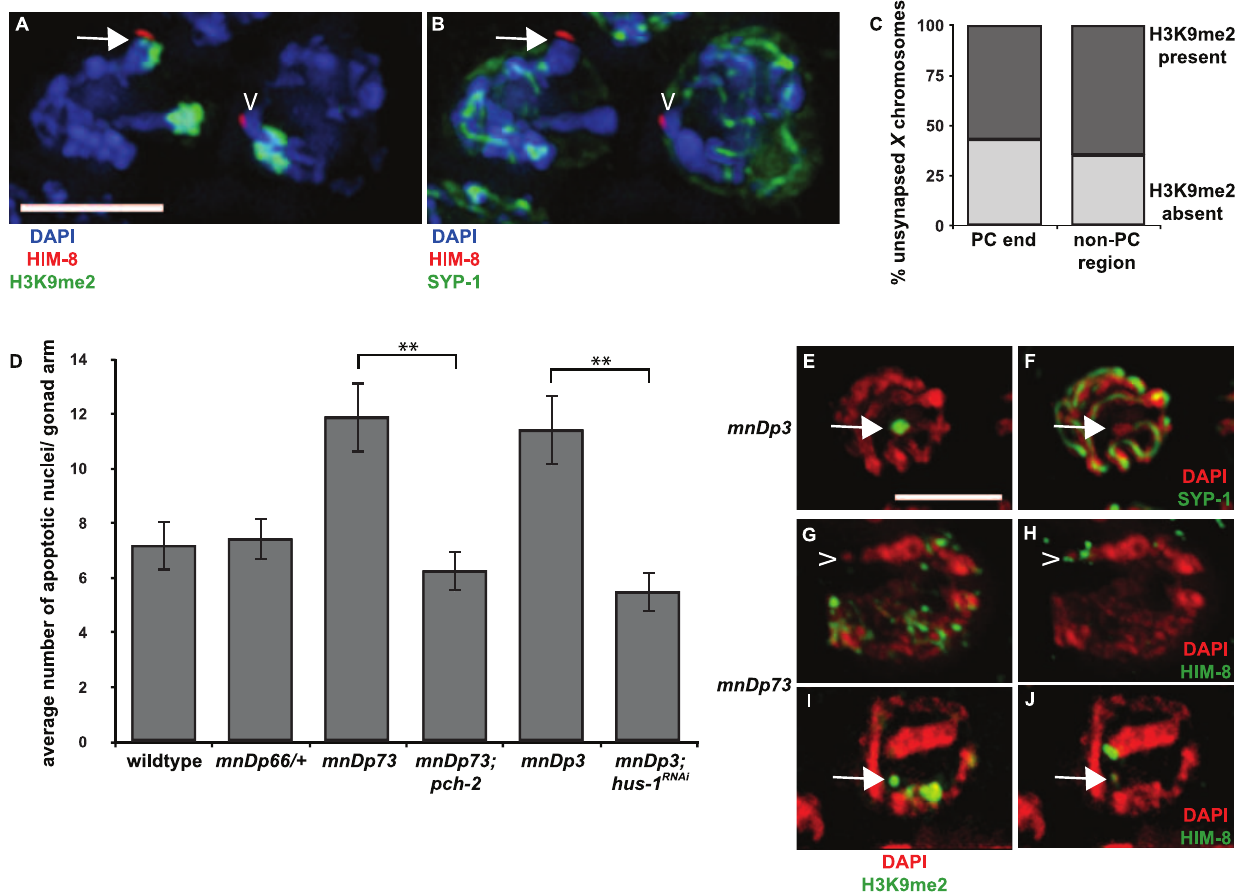
Figure 2. A chromosomal duplication with Pairing Center activity often does not undergo heterochromatin assembly. A and B. In meDf2/ + hermaphrodites, it is difficult to determine if PCs of unsynapsed X chromosomes become enriched with H3K9me2. Indirect immunofluorescence was performed on meiotic nuclei in meDf2 heterozygotes using antibodies against the X chromosome PC protein HIM-8, the central element component SYP-1 and H3K9me2. The nucleus on the left contains an unsynapsed X chromosome, as identified by HIM-8, an enrichment of H3K9me2 (A) and the absence of SYP-1 (B); the PC appears enriched with H3K9me2 (arrow in A). The nucleus on the right also contains an unsynapsed X chromosome, as indicated by the absence of SYP-1 in B, and the PC of this chromosome does not exhibit robust H3k9me2 (caret in A). C. Quantification of the percentage of unsynapsed X chromosomes in meDf2 heterozygotes that were enriched for H3K9me2 at their PC and non- PC regions. D. A chromosomal duplication with Pairing Center activity ( mnDp73 ) activates the synapsis checkpoint. A duplication that does not